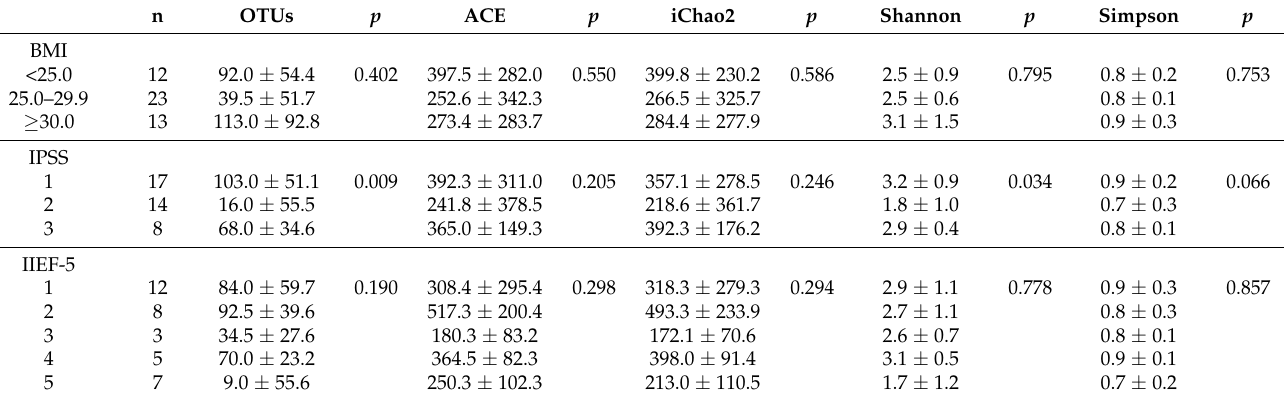
Table 2. Median alpha diversity indices ± standard deviation for body mass index (BMI) categories: normal, overweight, obese; International Prostate Symptom Score (IPSS): mild, moderate and severe bother; and International Index of Erectile Function (IIEF-5): 1 = no or mild erectile dysfunction, 5 = significant erectile dysfunction. OTUs—number of OTUs representing 95% of the community. Note the U-shaped curve in the OTUs column for BMI and IPSS. Despite the statistical significance ( p < 0.05), there is no discernible trend one would expect for an ordinary variable. We believe this to be due to sampling error.